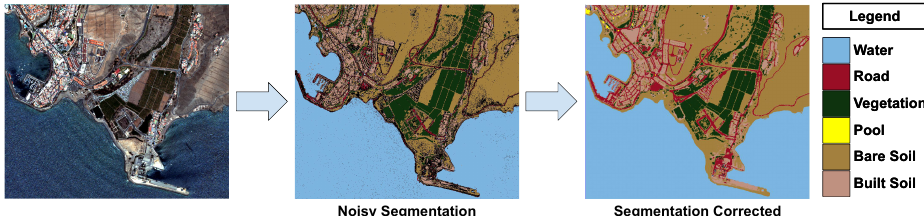
Figure 2. Manual relabeling and correction of the dataset for semantic segmentation.